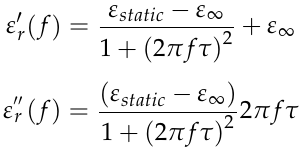
Figure 5. Average values of the measured dielectric constant versus frequency.